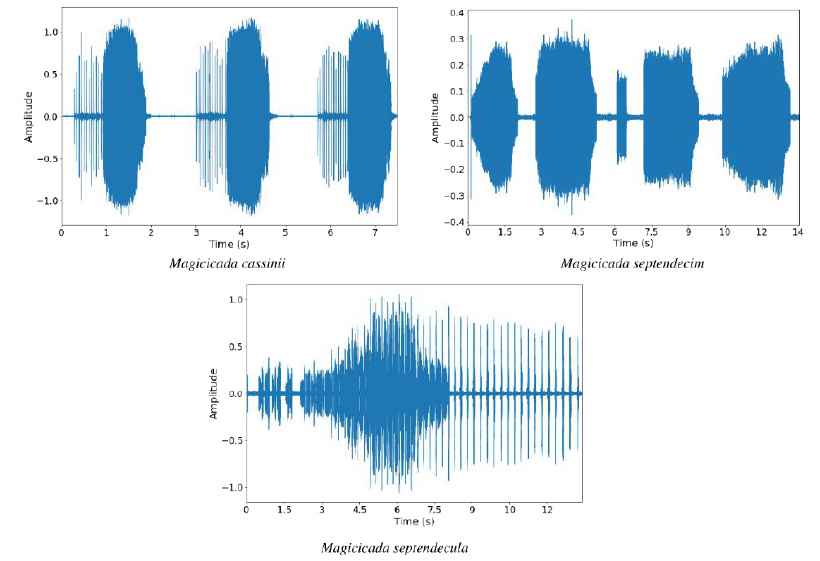
Figure 3. Waveform visualization of sounds of each species. Table 1. Details of audio recordings.